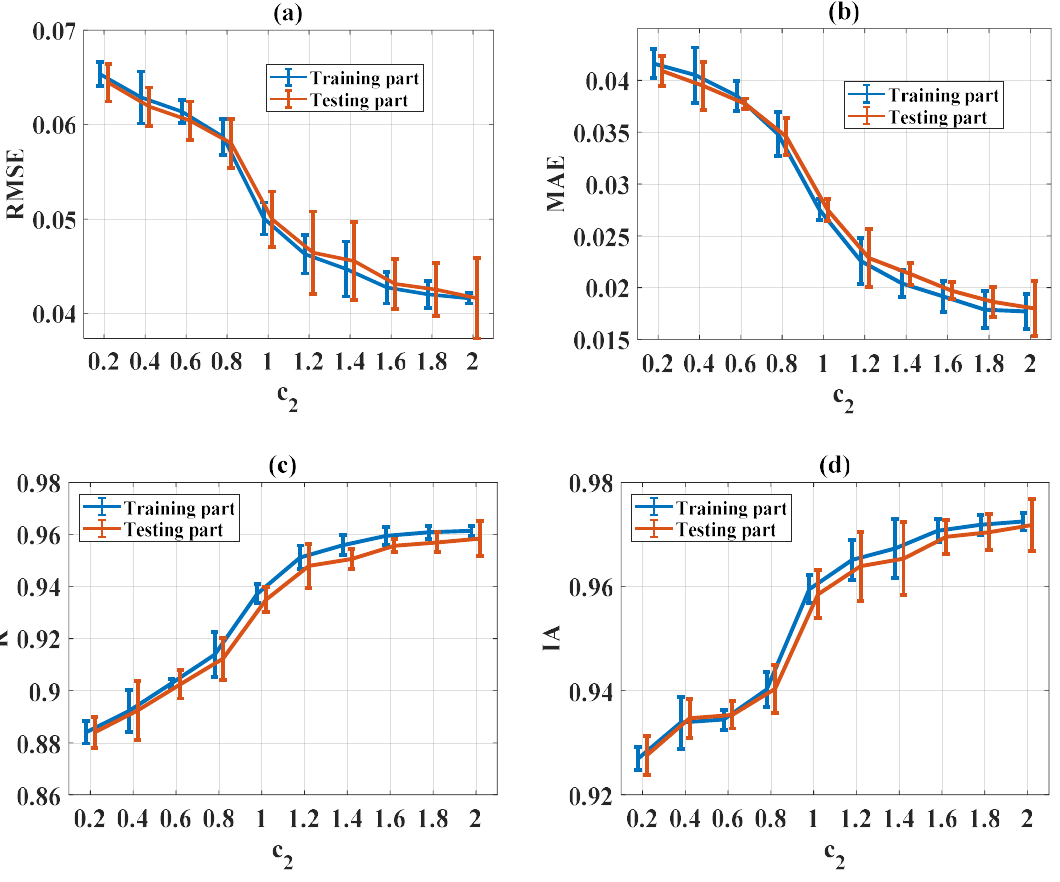
Figure 12. Evaluation of statistical criteria in the function of c 2 : ( a ) RMSE, ( b ) MAE, ( c ) R, and ( d ) IA.